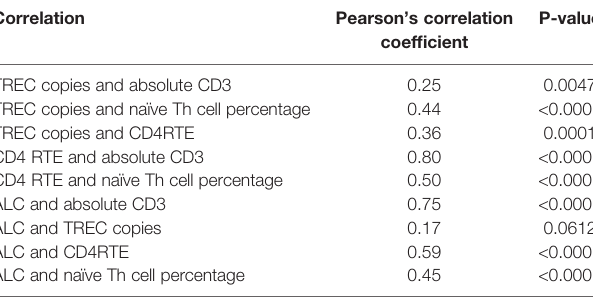
TABLE 5 | Pairwise correlations between immunologic parameters of interest. Correlation Pearson ’ s correlation coef fi cient